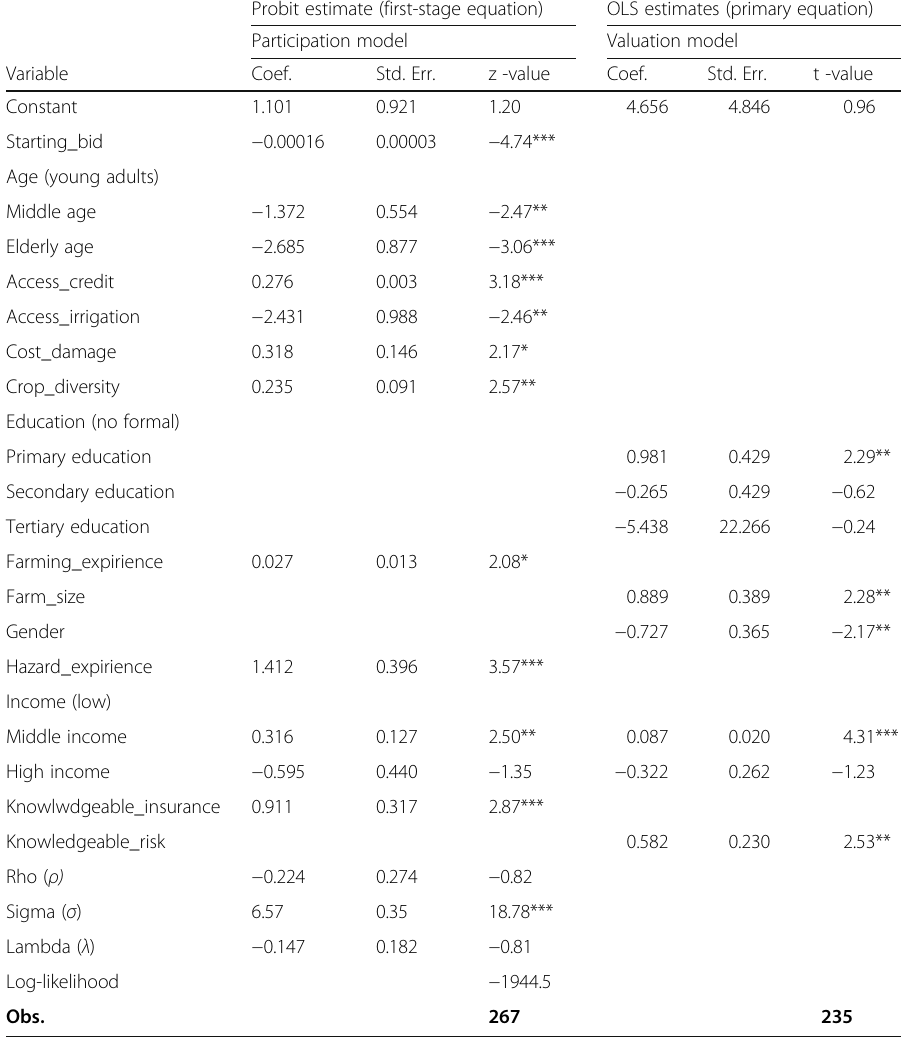
Table 4 Modeling results from Heckman ’ s 2-step estimation procedure Probit estimate (first-stage equation) OLS estimates (primary